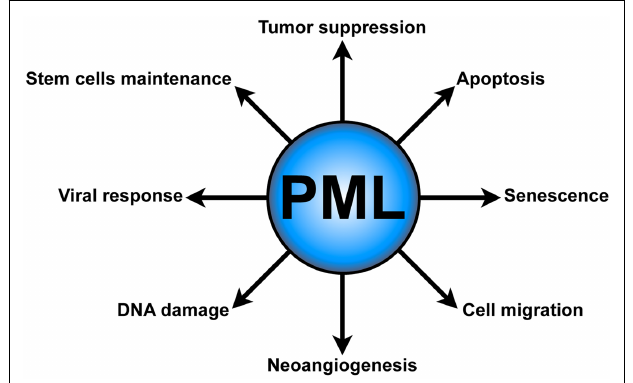
FIGURE 1 | PML functions. PML plays several critical cellular functions, such as apoptosis and senescence, neoangiogenesis, cell migration, DNA damage response, antiviral defense, and hematopoietic stem cell